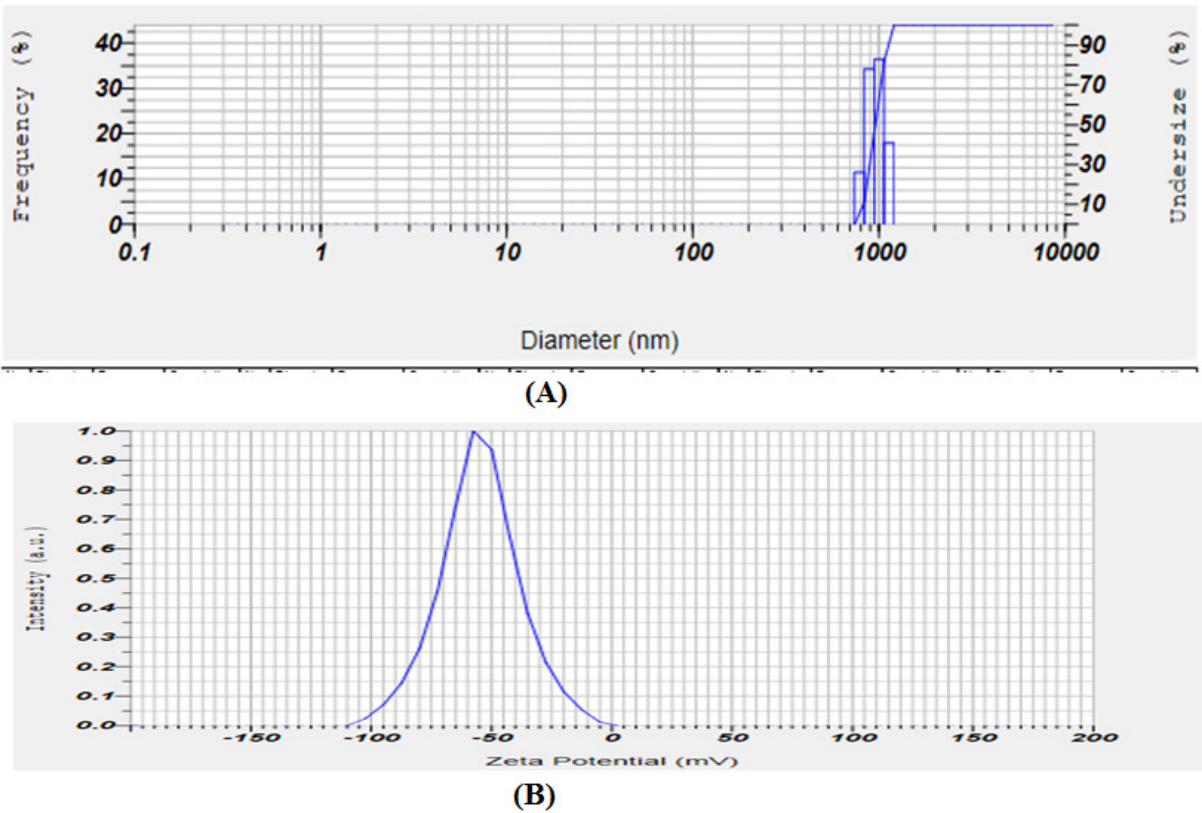
Figure 4. P. granatum ethosome particle size ( A ) and zeta potential ( B ) value.